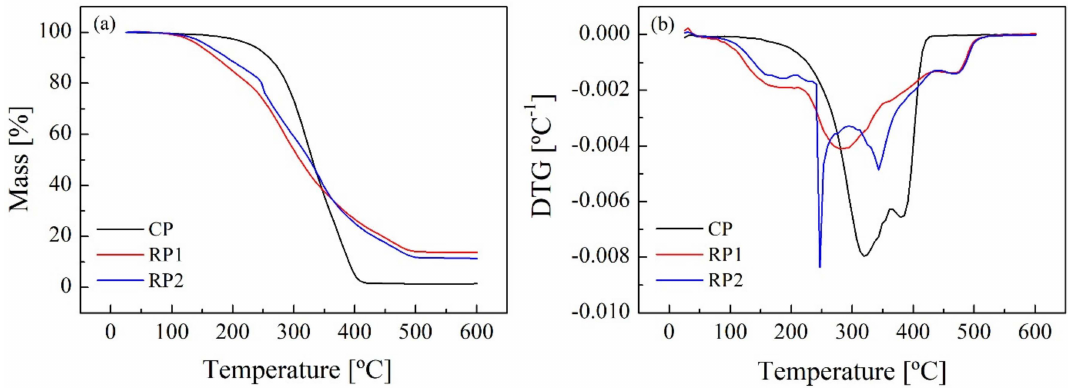
Figure 4. Thermogravimetric TGA ( a ) and DTG ( b ) curves of the polyols.